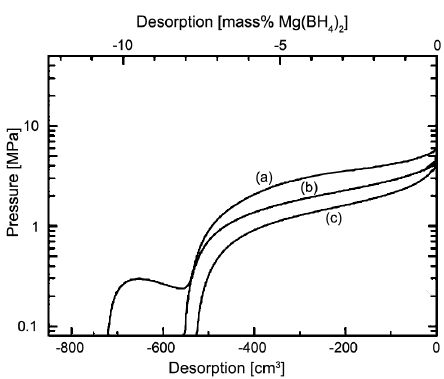
Figure 3. Absorption/desorption isotherms for Mg(BH 4 ) 2 as synthesised from LiBH 4 and MgCl 2 through heat treatment at 320 ◦ C: ( a ) desorption at 350 ◦ C; ( b ) desorption at 320 ◦ C; and ( c ) desorption at 290 ◦ C. Reprinted from [37].